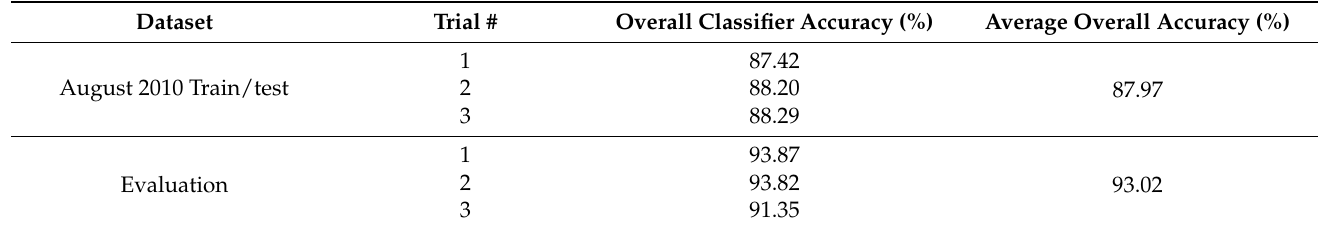
Table 2. Overall classifier accuracy (total correctly labeled detection images/total detection images) for the three different times (i.e., three trials) all the detection images from both datasets—train/test and evaluation—were classified by the data-augmented, trained classifier, as well as the average overall classifier accuracy for each